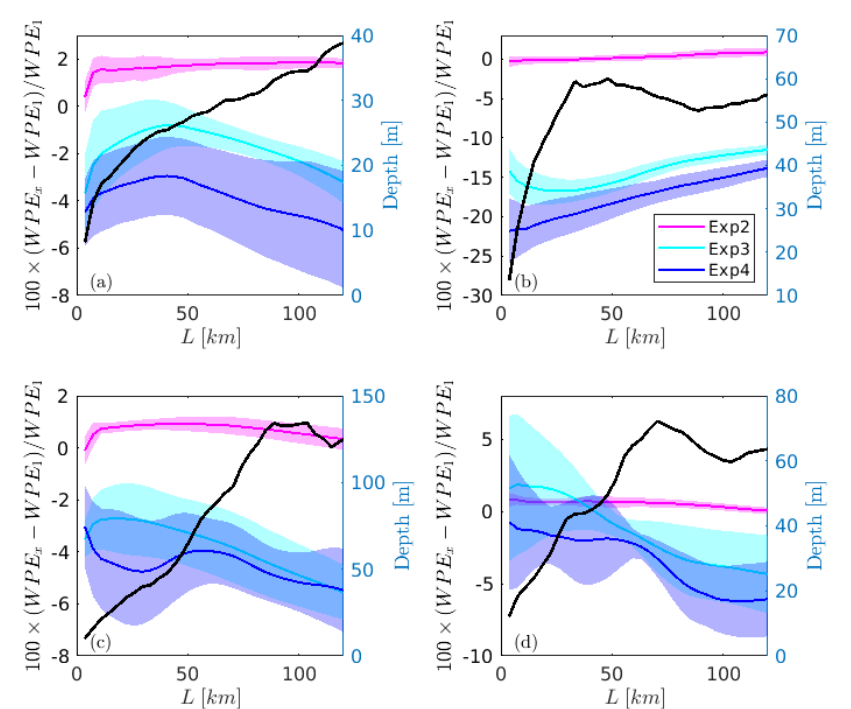
Figure 12. The relative difference of WPE between sensitivity experiments (i.e., Exp2, Exp3, and Exp4) and Exp1 for the four chosen areas: A ( a ), ( b ) B, ( c ) C and ( d ) D in January 2015. The shaded areas represent the standard deviation. The black solid lines represent the water depth changes with distance from the